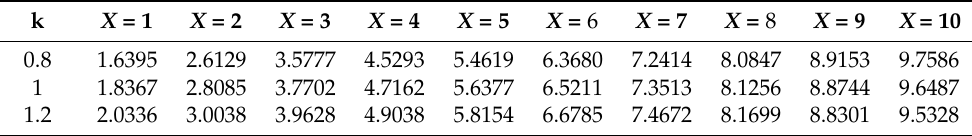
Table 7. Dependence of the function f m ( X ) value on the expert error k and the grade X in case 5, when µ = 8.5, σ =